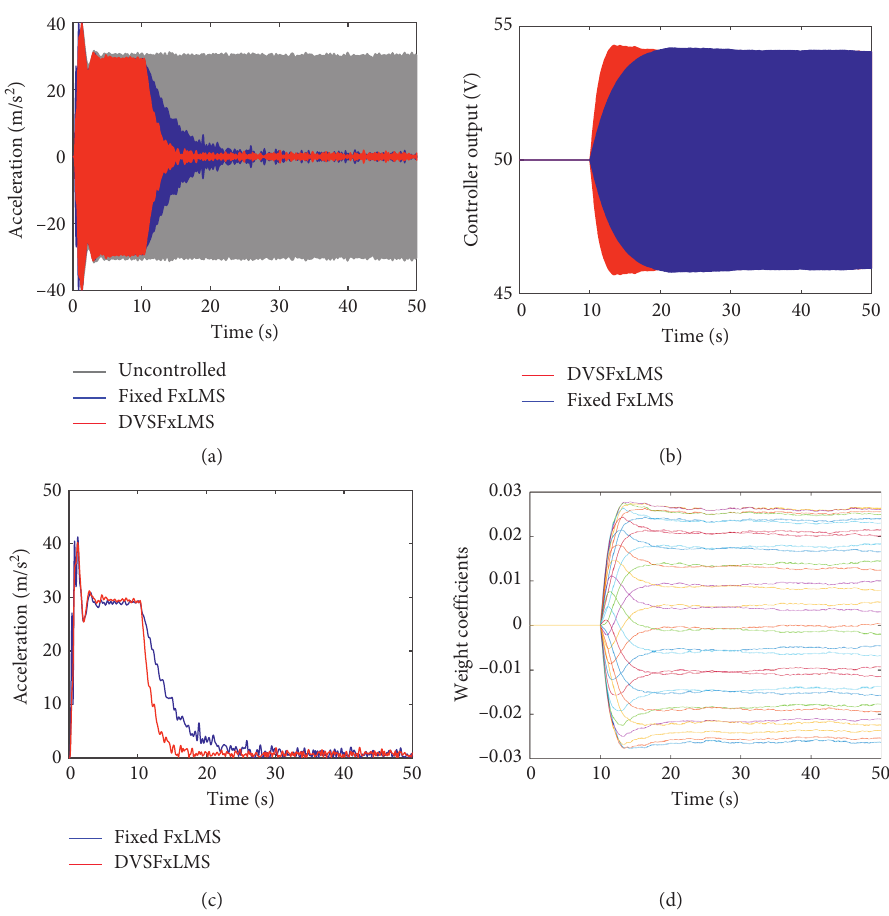
Figure 10: Comparison of experimental results of the DVSFxLMS controller: (a) acceleration response at point A; (b) output voltage; (c) peak acceleration response at point A; (d) adaptive filter weight coefficient iteration curves of the DVSFxLMS controller.